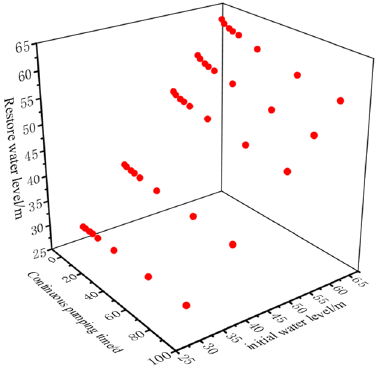
Figure 8. Restoration of water level at 1 d.